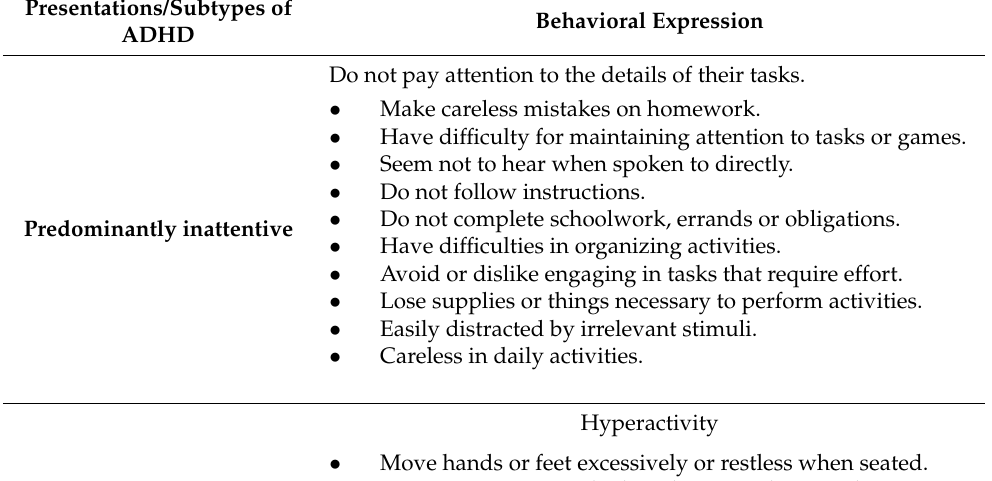
Table 1. Behavioral Expression of ADHD